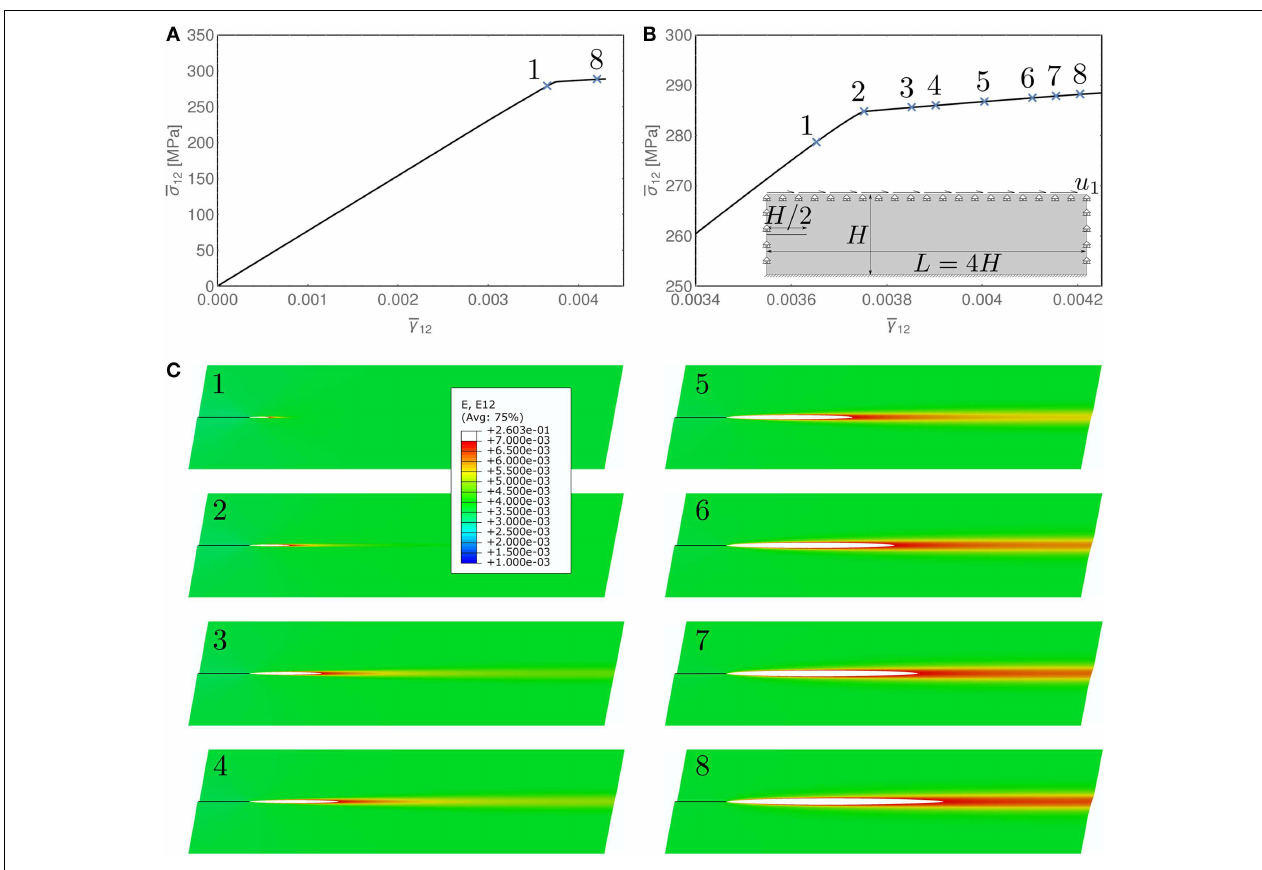
the overall response curve ¯ σ 12 − ¯ γ 12 around the stress level corresponding to the yielding of the shear band. (C) Contour plots of the shear deformation γ 12 at different stages of deformation, corresponding to the points along the overall response curve shown in (B) of the figure.The deformation is highly focused along a rectilinear path emanating from the shear band tip.The displacements in the figures are amplified by a deformation scale factor of 50.